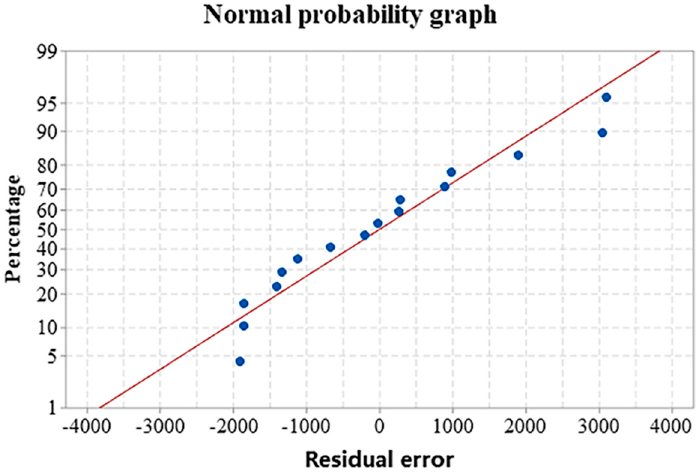
Figure 7. Normal probability of the pore area.